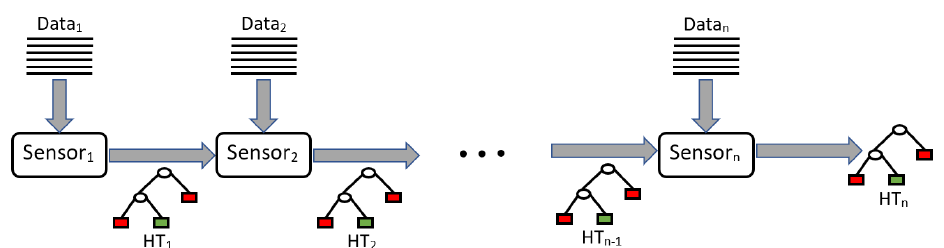
Figure 2. Incremental learning with Hoeffding